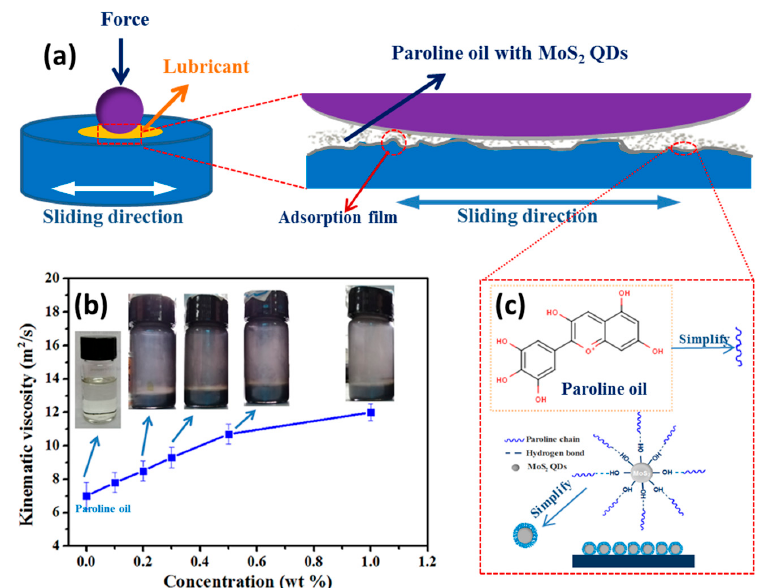
Figure 9. Schematic diagram of the lubricating mechanism: ( a ) ball-on-disc friction model; ( b ) viscosity with respect to additive amount; ( c ) adsorption process of paroline oil with MoS 2 QDs. Because the spherical MoS 2 QDs function as ball-bearing lubricants in the process of friction, they can be adsorbed onto the slide track by adding MoS 2 QDs to pure paroline oil to prevent the frictional component from contacting it directly [30,31]. In summary, the synergistic lubrication e ff ect of the tribo-film, the improvement of the bearing capacity, and the ball-bearing e ff ect together lead to the lowest friction and